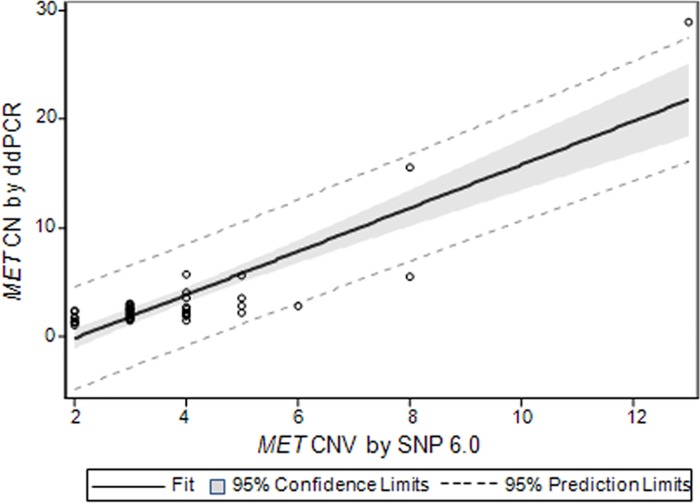
Measurement of MET copy number in cancer cell lines using ddPCR versus SNP 6.0.The data is based on a linear regression model that adjusts for SNP 6.0 with intercept. Solid line indicates fitting curve; gray box represents 95% confidence limits; dashed line depicts 95% prediction limits. Each data for MET CN using ddPCR represents two or three merged technical replicate wells with no template control (NTC) as a negative control.